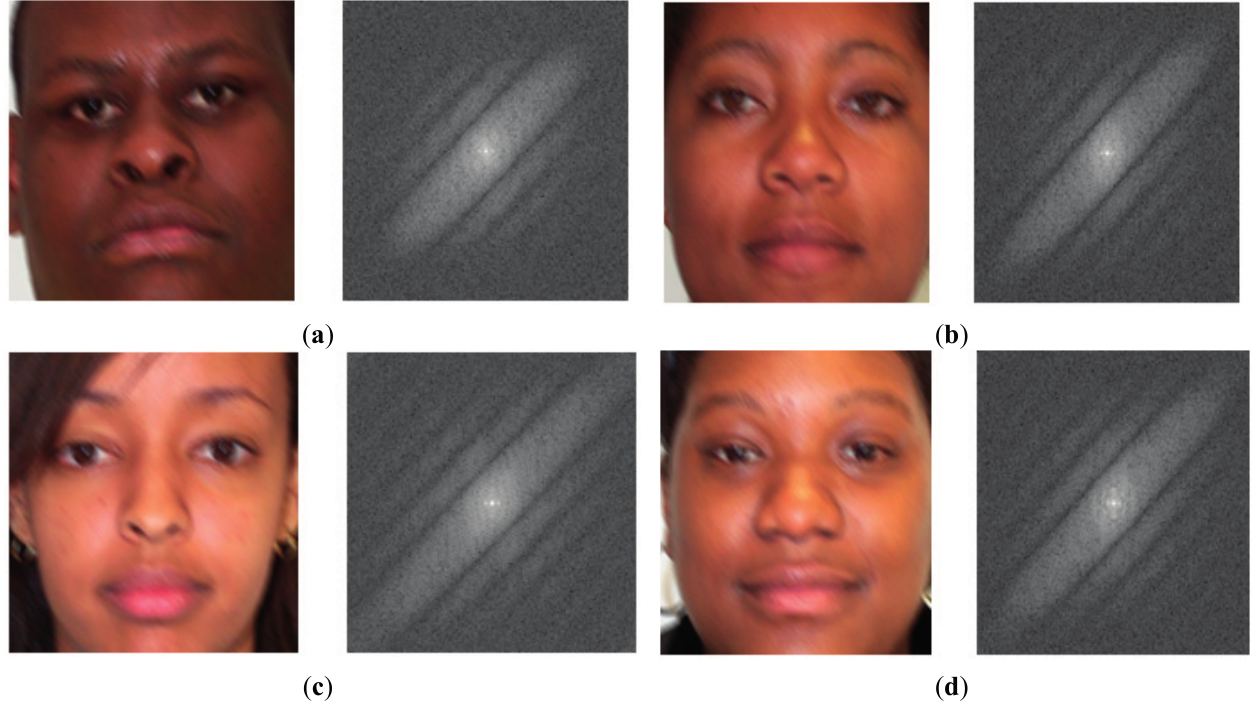
Figure 4. Implementation result examples for Hann windowing method for removing boundary artifacts on images in Figure 3: ( a – d ) the four examples of results by Hann windowing